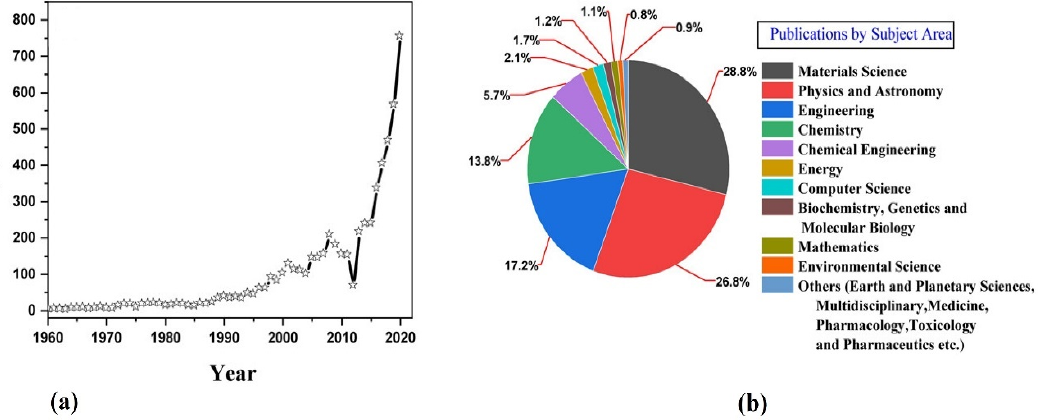
Figure 1. ( a ) the number of publications of gallium oxide over the years from 1960 to 2020. ( b ) the number of publications based on subject area [21]. “Reprinted with permission from Ref. [21]. Copyright (2017), Elsevier”.